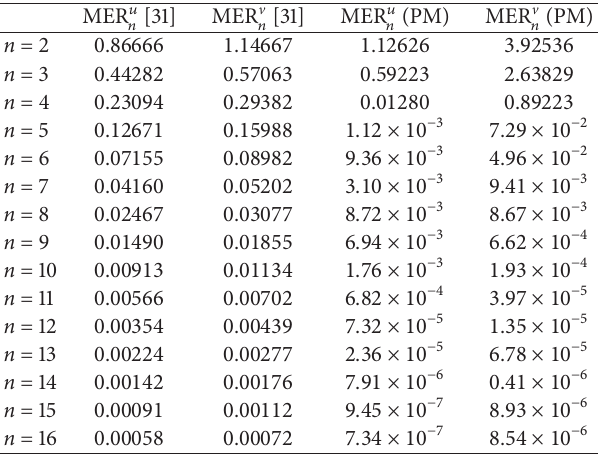
Table 5: Maximal error of Example 5 obtained with the proposed method and its comparison with error reported in